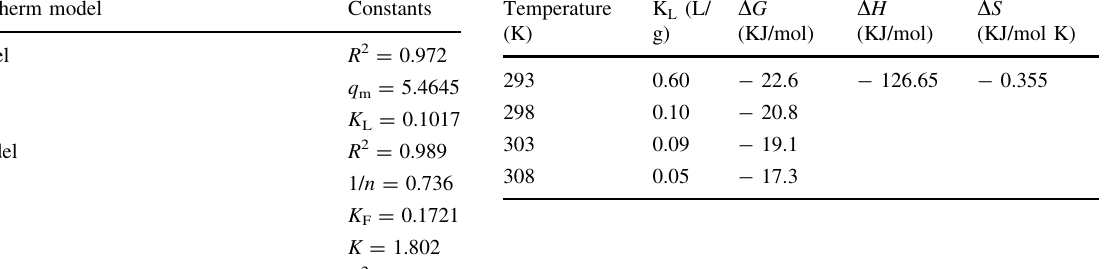
Table 6 Values of equilibrium parameters Adsorption isotherm model